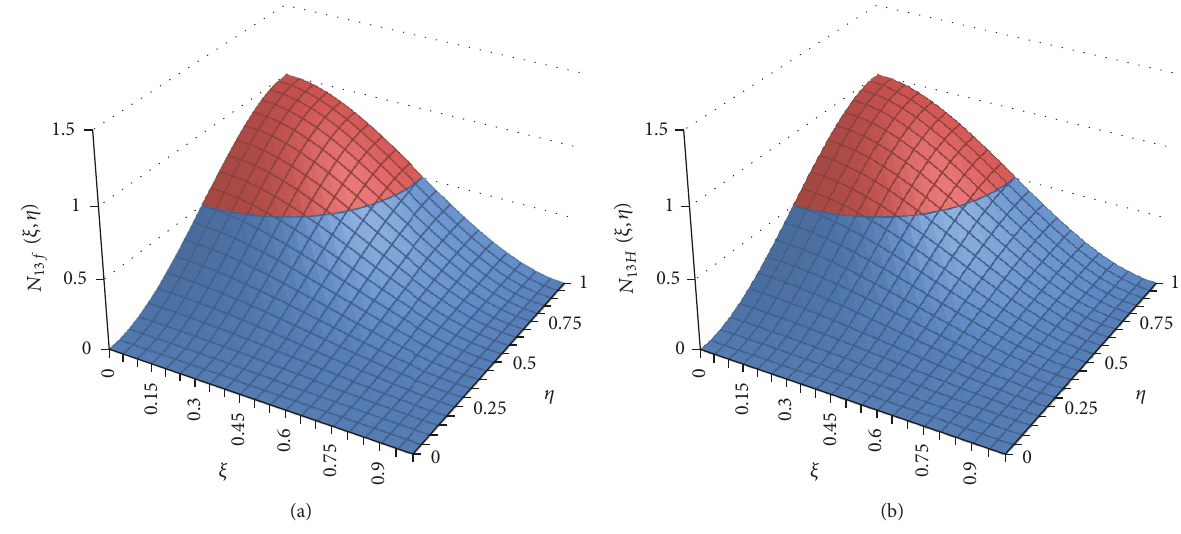
Figure 8: DFE (a) and FEM (b) shape function for 𝑤 4 at node 4.